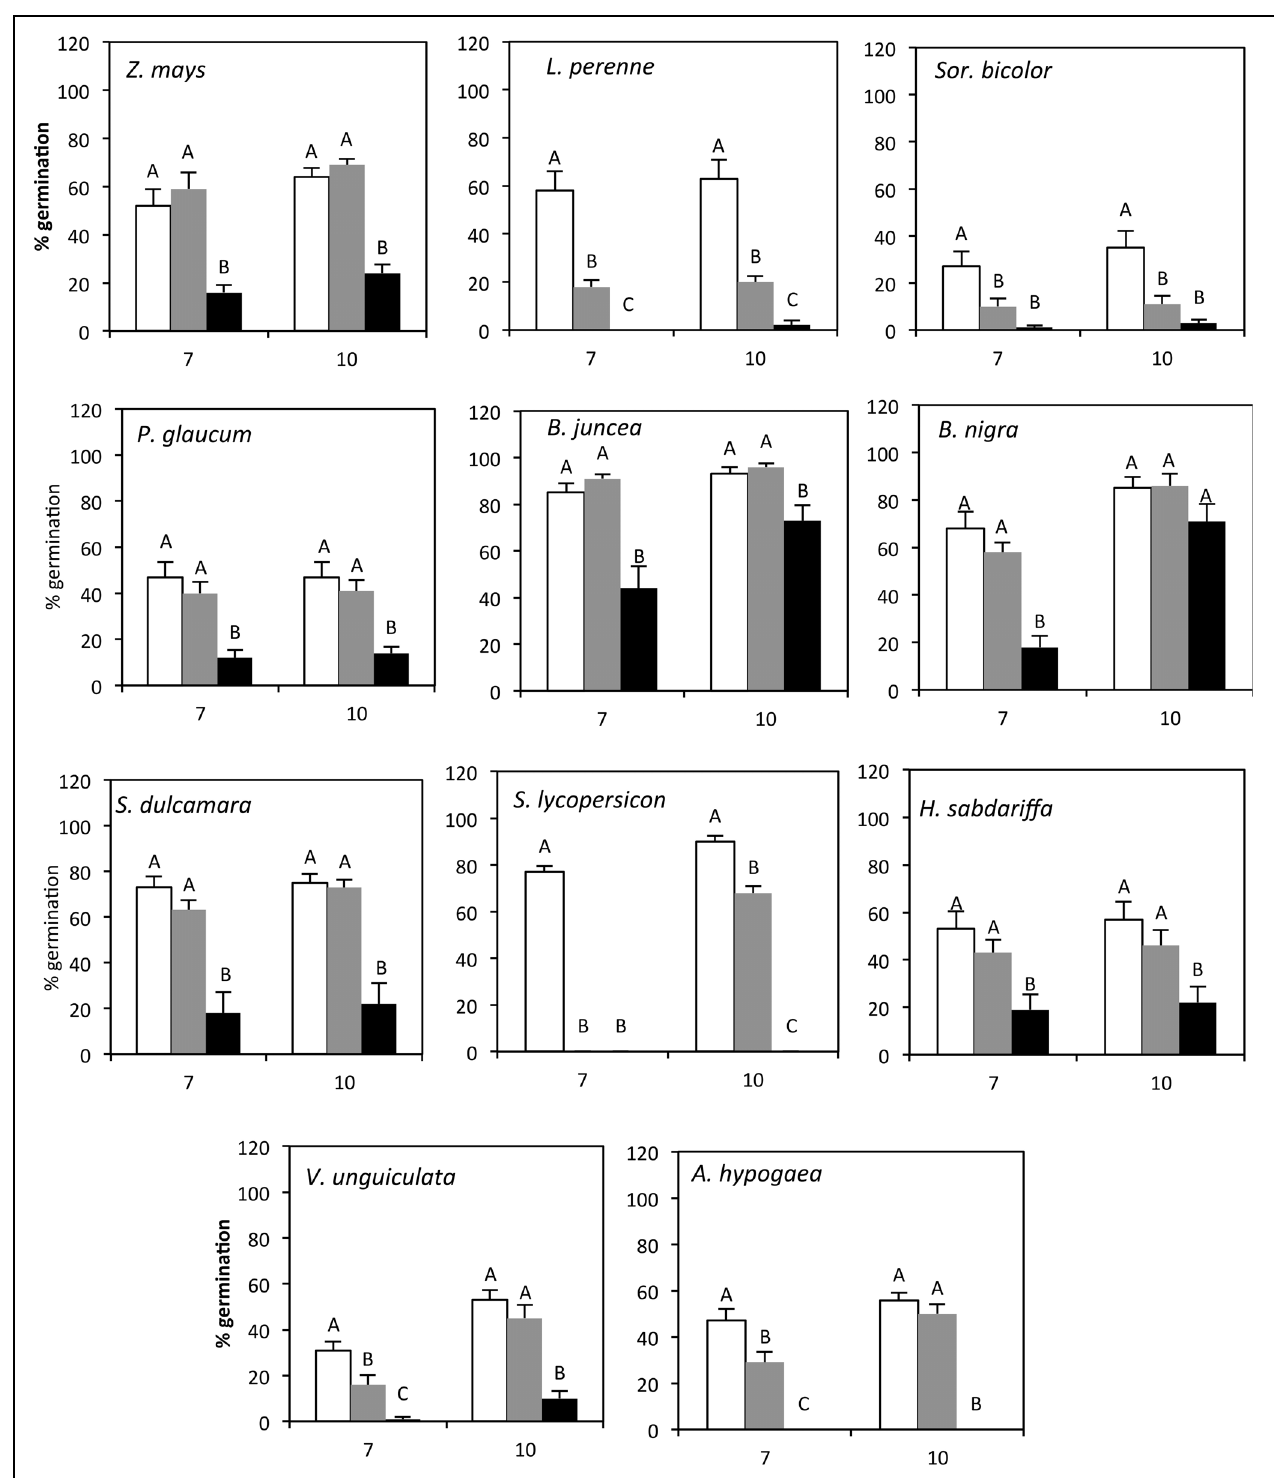
FIGURE 3 | Germination percentages ( + SEM) at 7 and 10 days after sowing per treatment group: Control (white open bars), Low (gray bars), and High (black bars). Different letters represent statistically significant differences in germination (One-way ANOVA, Tukey mean separation, p < 0.05).